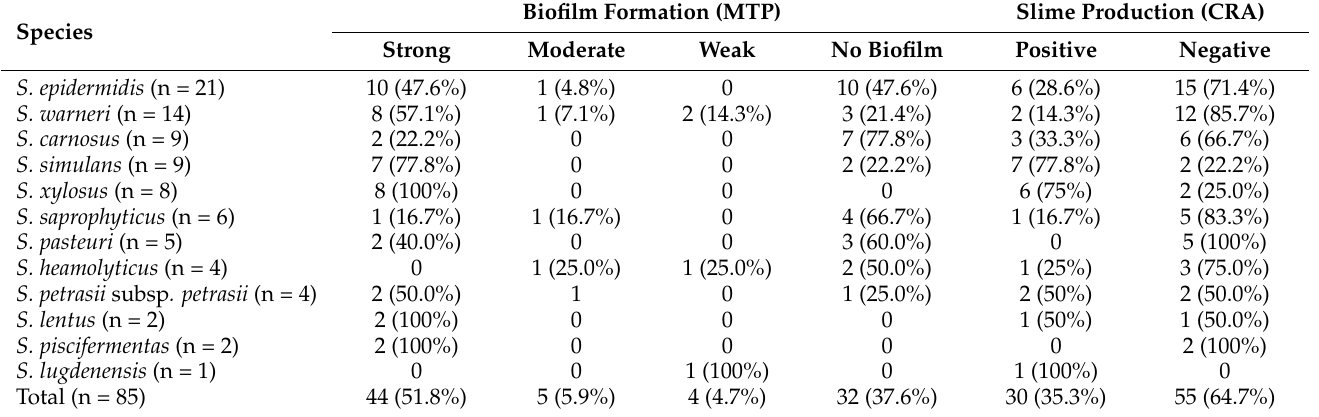
Table 1. Biofilm formation of the tested CoNS by the quantitative (MTP) and qualitative (CRA)